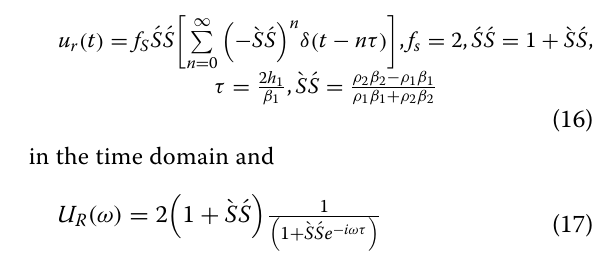
ing, nearly vertical SV waveform incidents to this struc- ture model, a radial-component elastic response at the sediment top is approximately given by